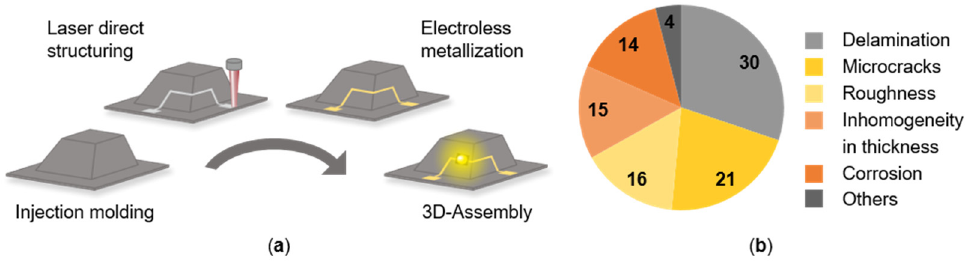
Figure 1. ( a ) Schematic depiction of the LDS-MID process chain; ( b ) Percentage of main causes of failure of conductor tracks on MID, according to Ref [4].